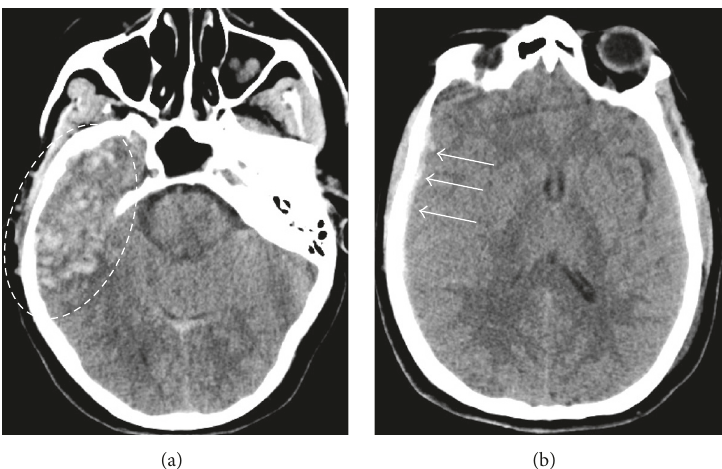
Figure 1: Computed tomography (CT) of the head. CT head showed a right temporal contusion with mixed density and surrounding vasogenic edema (dashed circle; (a)). She also had a small right frontal subdural hemorrhage (arrows; (b)).